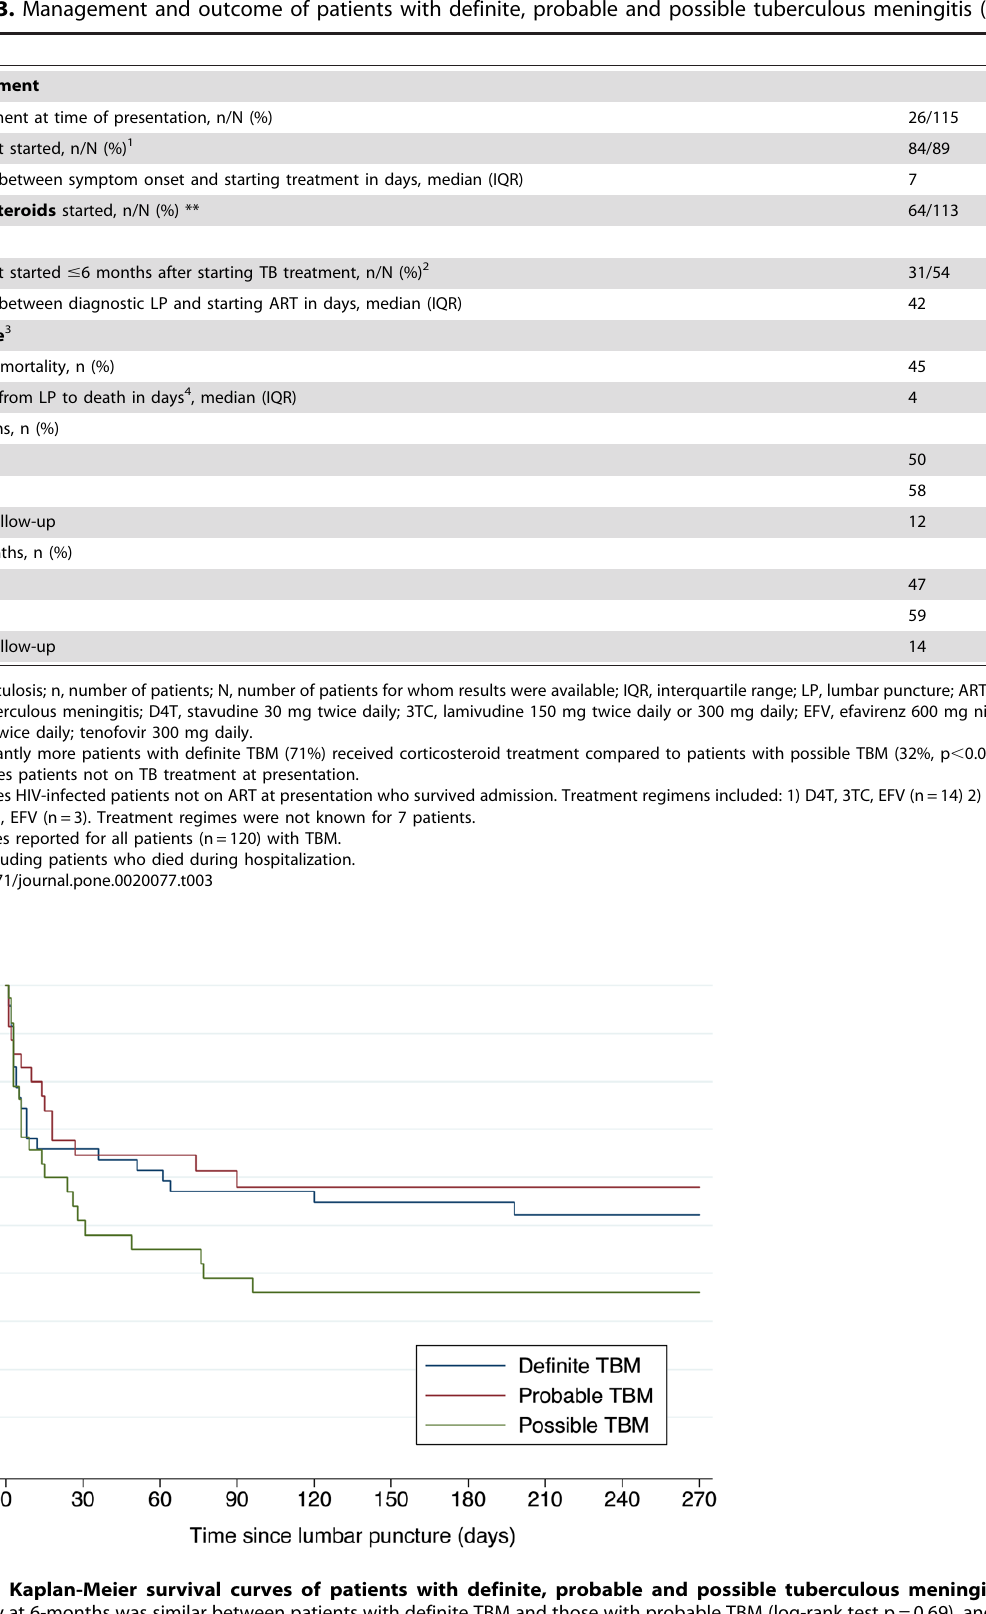
Table 3. Management and outcome of patients with definite, probable and possible tuberculous meningitis (n= 120).